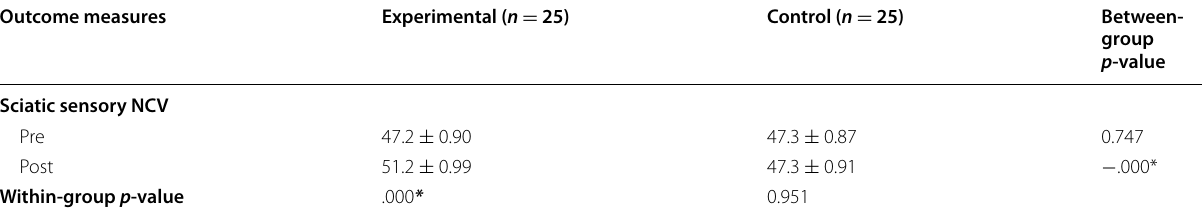
∗ Significant at alpha level < 0.05